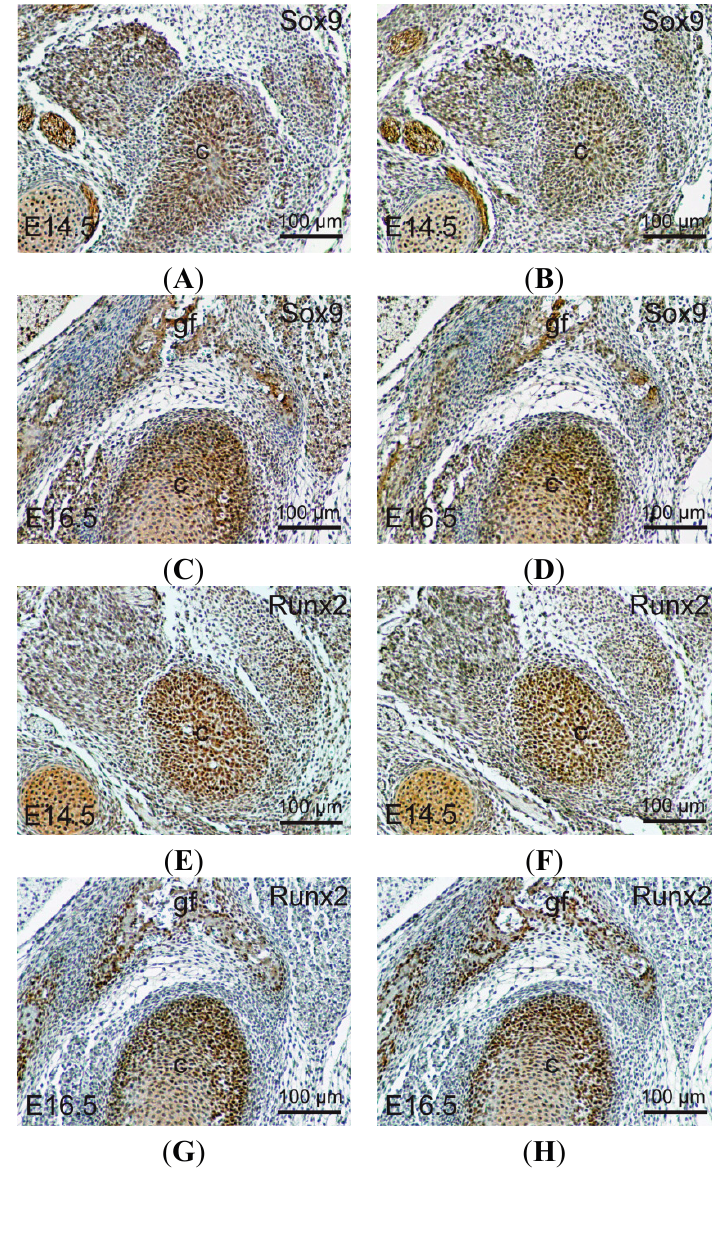
Figure 3. Expressions of Sox9, Runx2 and Ihh in the developing TMJ of Wnt1-Cre ; pMes-stop Shox2 mice. ( A – D ) Immunohistochemical staining shows Sox9 expression in the developing condyle of E14.5 ( A , B ) and E16.5 ( C , D ) wild type and Wnt1-Cre ; pMes-stop Shox2 embryo; ( E – H ) Immunohistochemical staining shows Runx2 expression in the developing TMJ of E14.5 ( E , F ) and E16.5 ( G , H ) wild type and Wnt1-Cre ; pMes-stop Shox2 embryo; and ( I , J ) In situ hybridization shows Ihh expression in the developing condyle of E15.5 wild type and Wnt1-Cre ; pMes-stop Shox2 embryo. c, condyle; and gf, glenoid